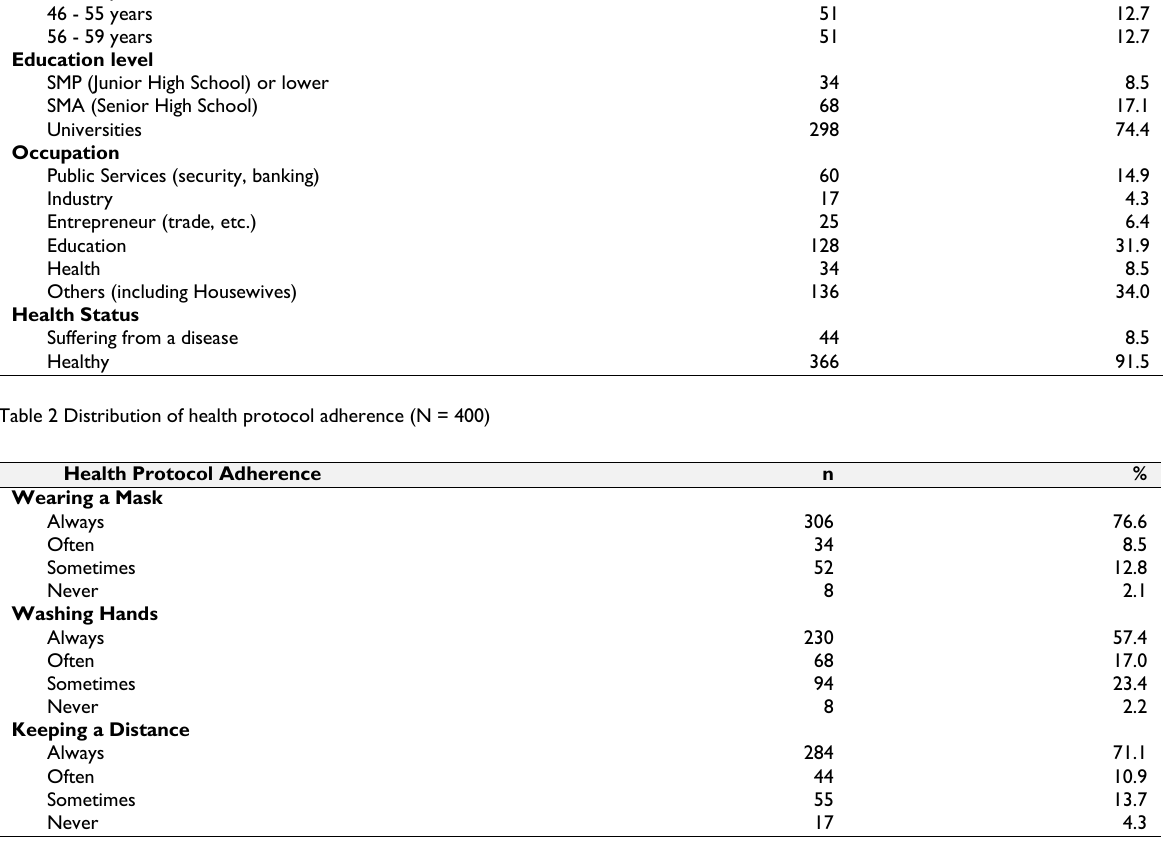
Table 3 Distribution of reasons for complying with health protocols (N = 400)